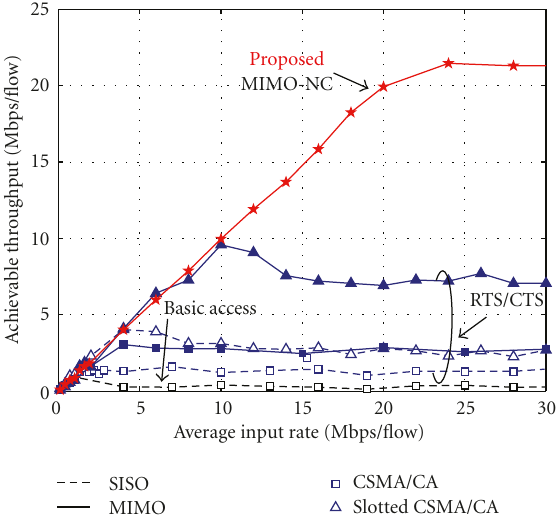
Figure 14: Throughput performance comparison of CSMA/CA and MIMO network coding (light tra ffi c).